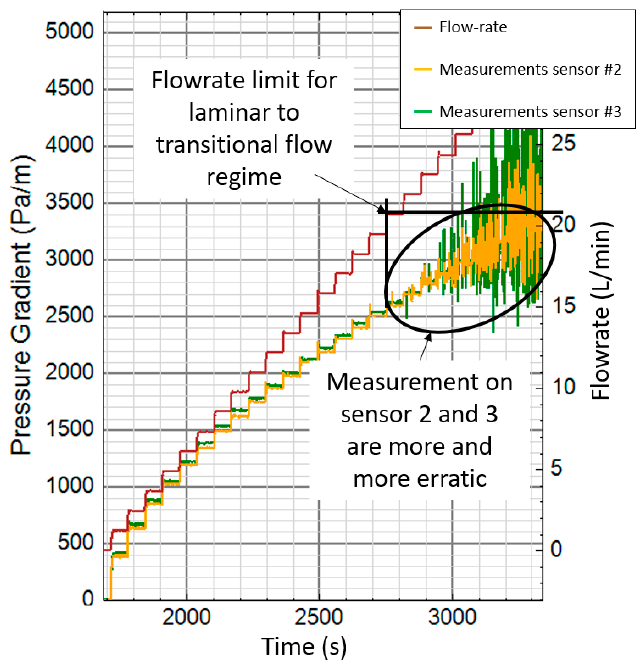
Figure 12. This graph shows how the measured differential pressures start to be more and more erratic, the more the Reynolds number overpasses the laminar to transitional limit.